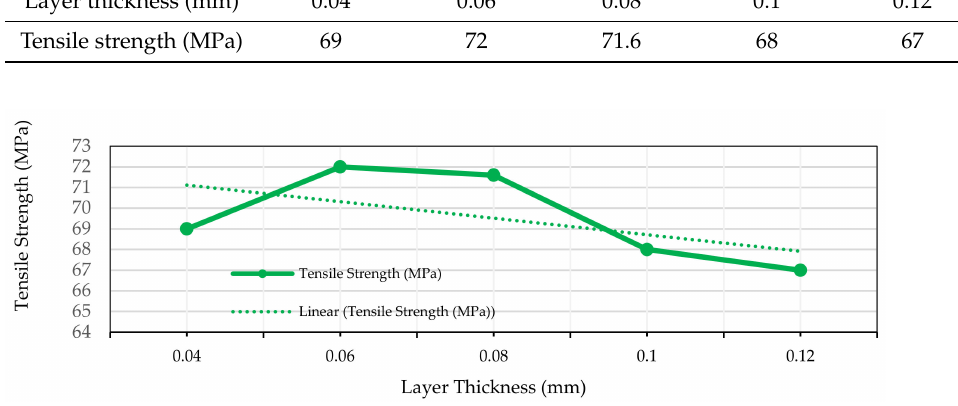
Figure 8. Tensile strength vs. layer